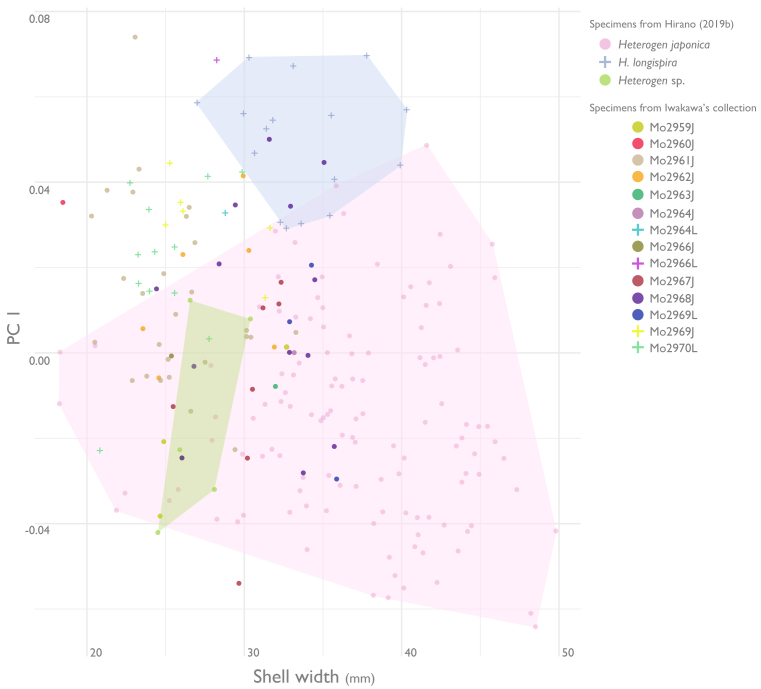
Plots of principal component axis one versus shell width for specimens from Iwakawa and Hirano et al. (2019b). The morphospace occupation by specimens from Hirano et al. (2019b) is also shown as coloured polygons.